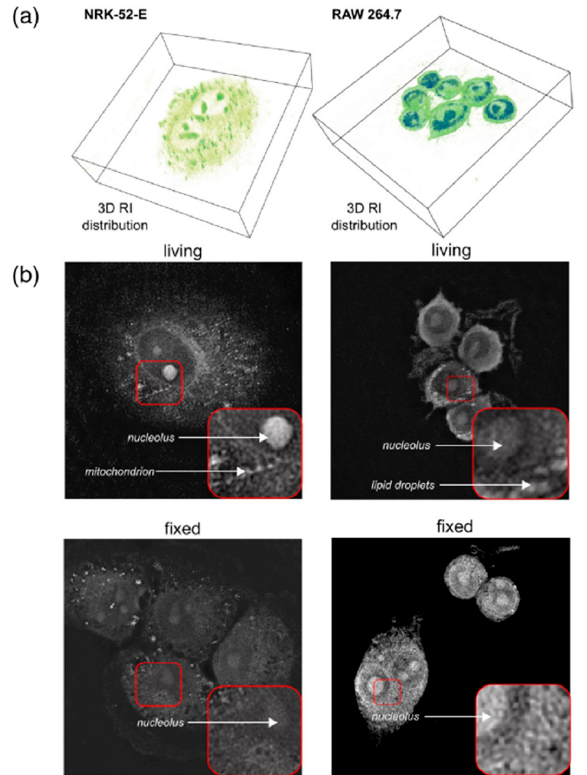
Figure 9. The holographic tomography measurements and analysis of four cell lines: ( a ) 3D visuali- zation of cell lines NRK-52E and RAW 264.7, ( b ) 2D refractive index distribution cross-section of the